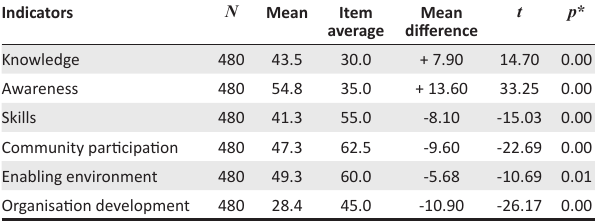
TABLE 8: Respondents’ disaster risk management components.